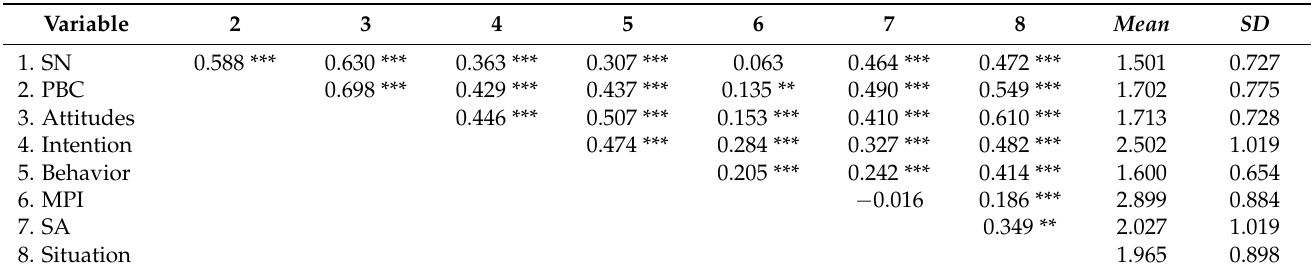
Table 5. Spearman correlations between